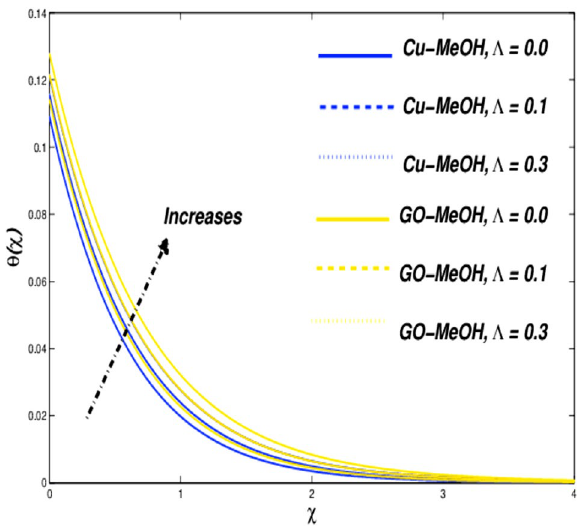
Figure 14. Temperature variation versus (cid:31) .